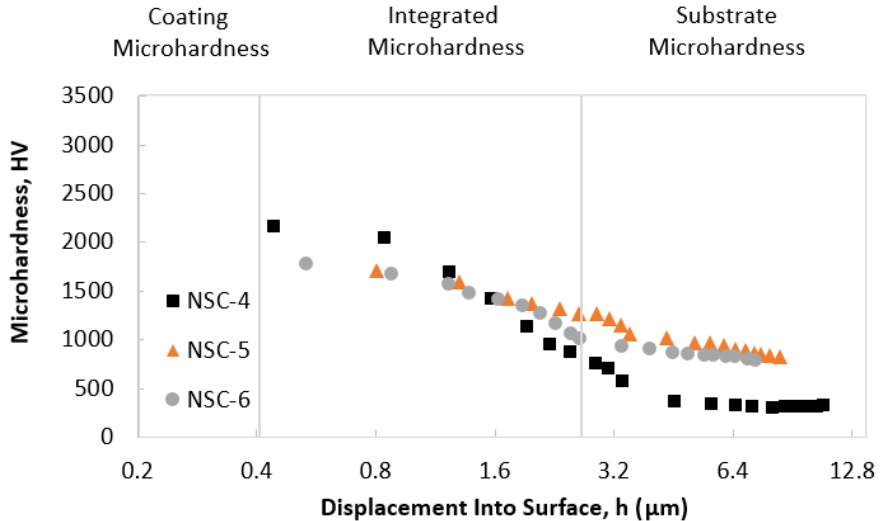
Figure 7. Microhardness dependence on displacement into the surface for the NSC samples doped with atomic element Nb (NSC-4 — black, NSC-5 — orange, NSC-6 — grey). The graph is divided into three parts characterizing coating microhardness, integrated microhardness, and substrate